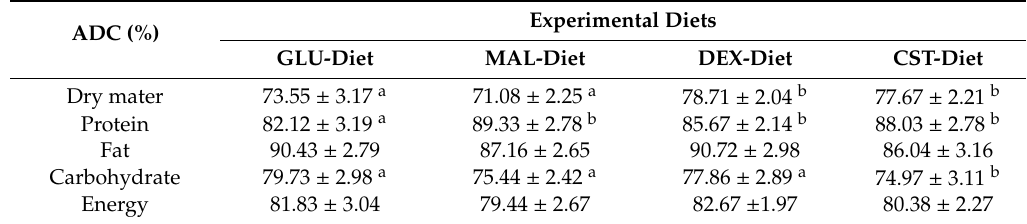
Table 3. Apparent nutrient digestibility coe ffi cients (ADCs) of experimental diet components.